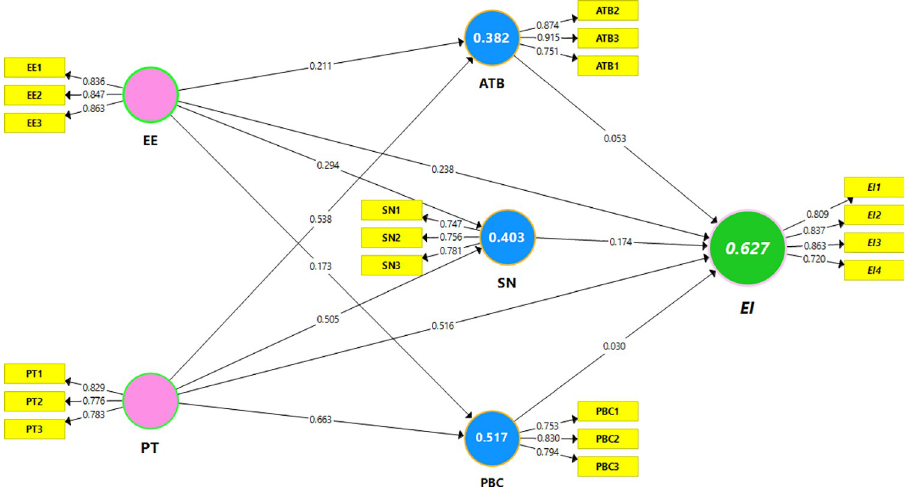
Fig 2. PLS-SEM Co-efficient path model